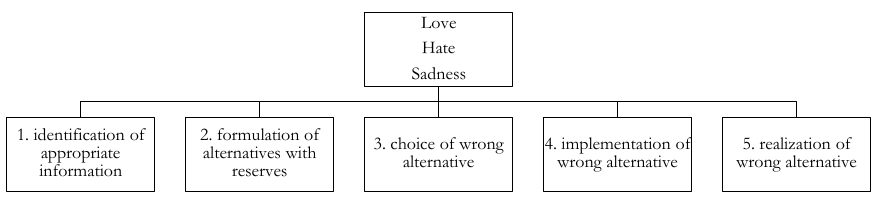
Fig. 1 – Concept of actuation of three key behavioral factors. Source: own research